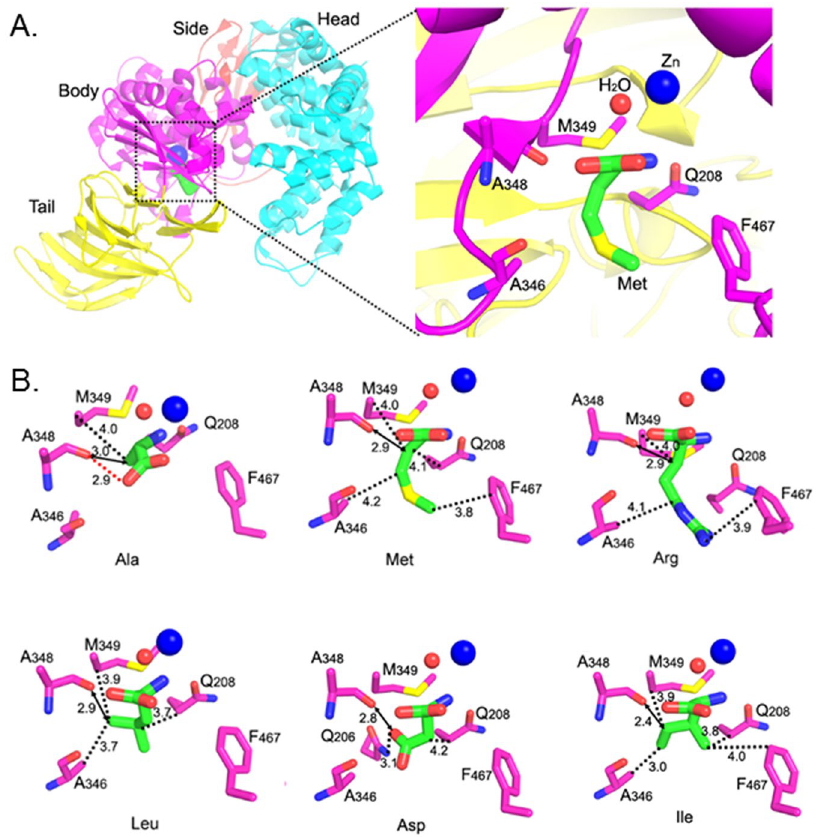
Figure 3. Crystal structures of pAPN complexed with free amino acids. ( A ) The amino acid-binding pocket in pAPN. Left: the overall structure of pAPN complexed with methionine (in green). Right: an enlarged view of the amino acid-binding pocket in the pAPN body domain. The orientation of the view on the right is derived by rotating the view on the left 90° clockwise along a vertical axis. ( B ) Crystal structures of pAPN complexed with amino acids that are favored (Ala, Met, Arg and Leu) and disfavored (Ile and Asp) P1 residues for APN. pAPN residues are in magenta, and amino acids are in green. The catalytically critical hydrogen bond between the carbonyl oxygen of Ala348 and the C-terminal carboxyl group of amino acids is shown as a red dashed line in the structure with Ala, but is omitted in other panels for clarity. The interactions between the carbonyl oxygen of Ala348 and amino acid side chains are shown as black dashed lines. The distance between the carbonyl oxygen of Ala348 and the nearest atom on amino acid side chains is shown as a bidirectional